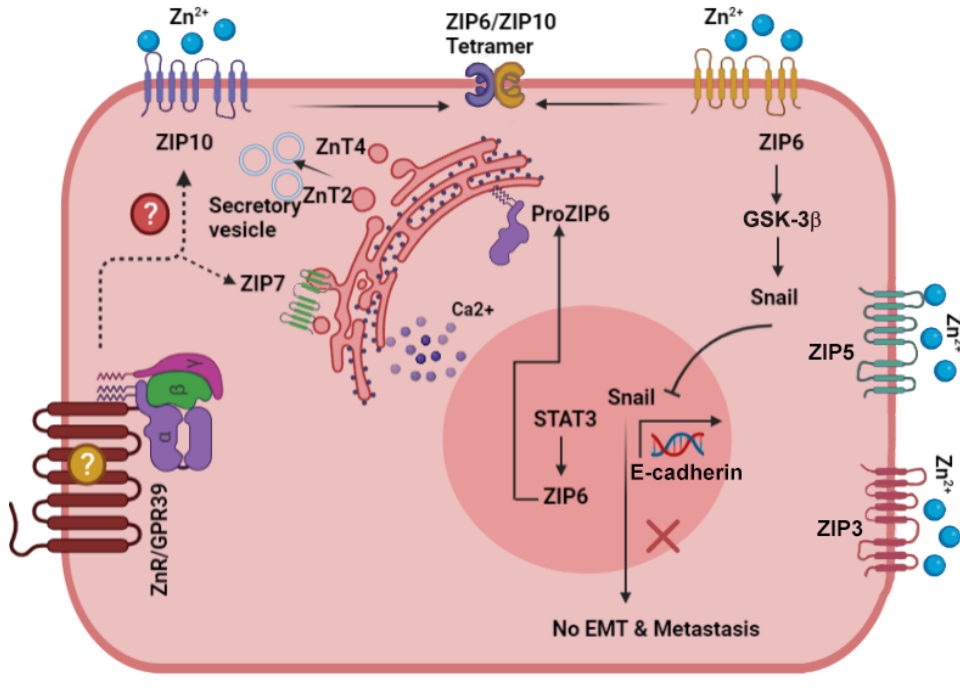
Figure 1. Scheme describing the main signaling pathways activated by Zn 2+ in the normal mammary gland cells. The Zn 2+ transporters that play a role in mammary gland physiology and their localization are described in the figure. In particular, note ZnT2, that plays a role in vesicular Zn 2+ accumulation during lactation and involution, and ZIP3/ZIP5, that were suggested to mediate Zn 2+ influx. Arrows depict established pathways, while dotted lines and question marks are putative pathways that remain to be explored.